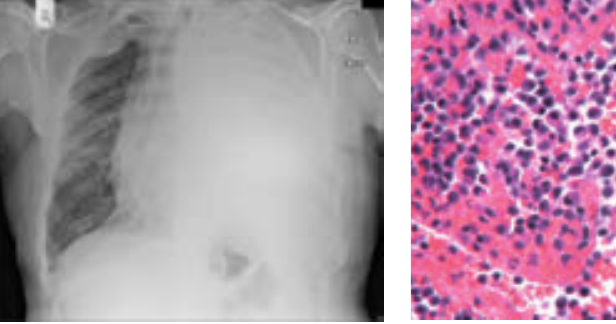
Figure 1. Chest radiographs showed a large left sided pleural effusion.